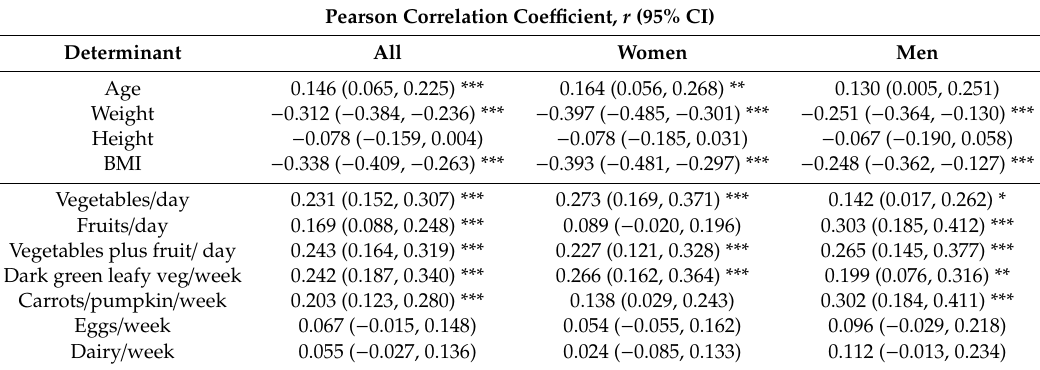
Table 3. Correlation of carotenoid reflection scores with participant characteristics and diet.